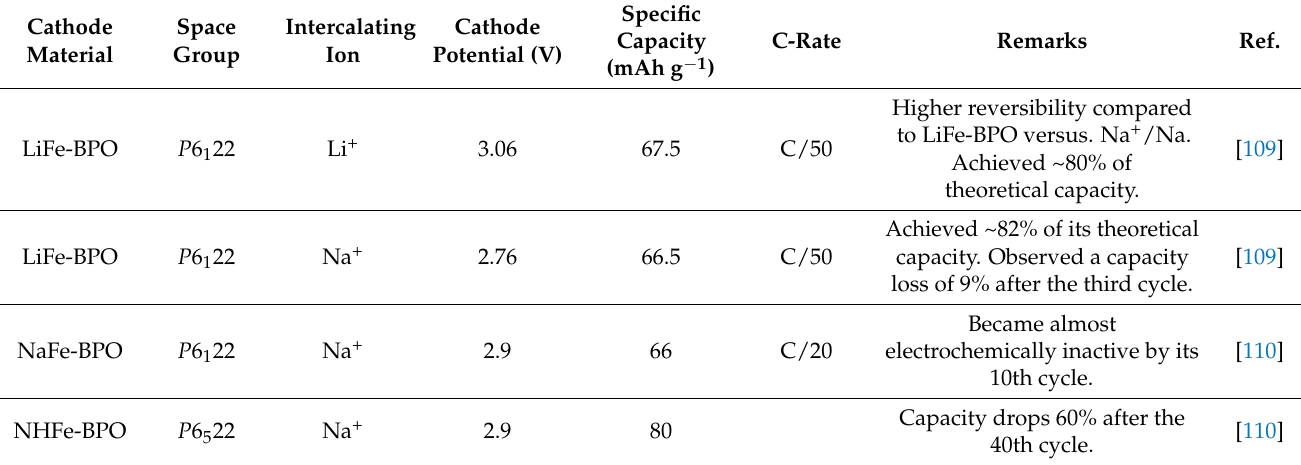
Table 5. Electrochemical performance of the BPO cathode materials.